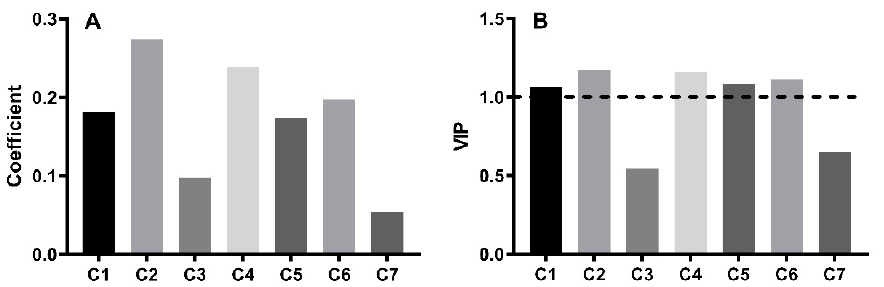
Figure 4. Spectrum-effect relationship analysis between the phytochemical profile and IL-6 level: ( A ) Regression coefficient. ( B ) VIP value.